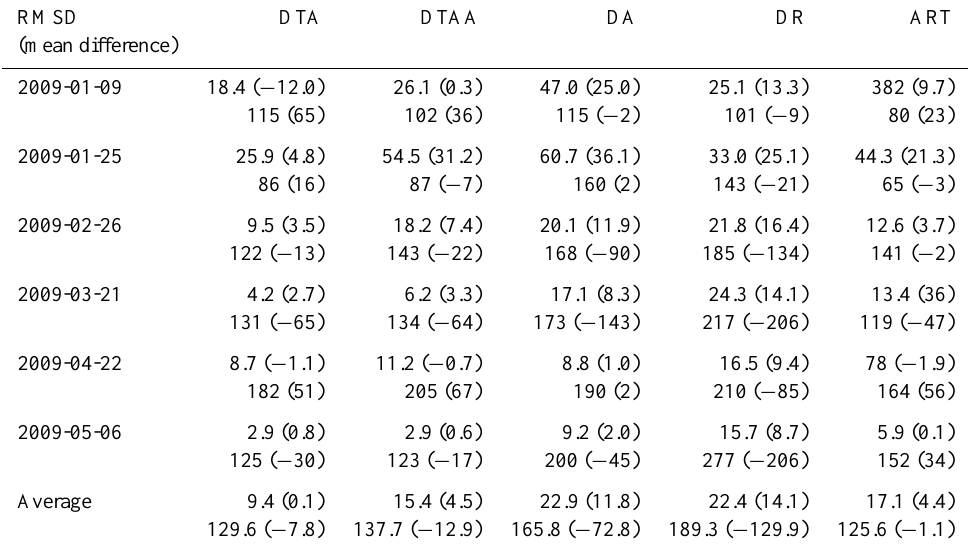
Table 7. Root mean square deviation (and mean difference in parenthesis) of the methods over the six studied dates. SSA on first line (m 2 kg − 1 ), optical radius on second line (µm). The number of pixels on which the computations were carried out is similar to Table 6. RMSD DTA